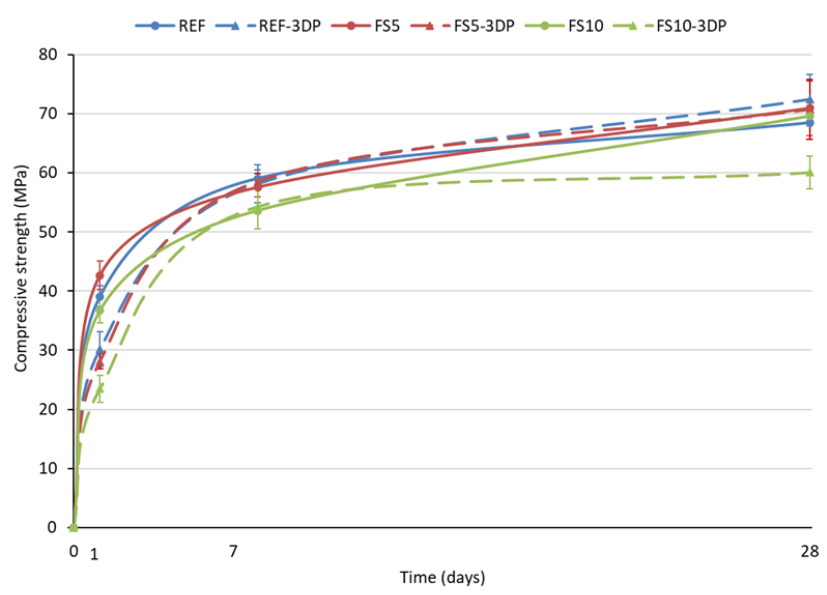
Figure 13. Compressive strength of nonprinted and printed mortars at 1, 7, and 28